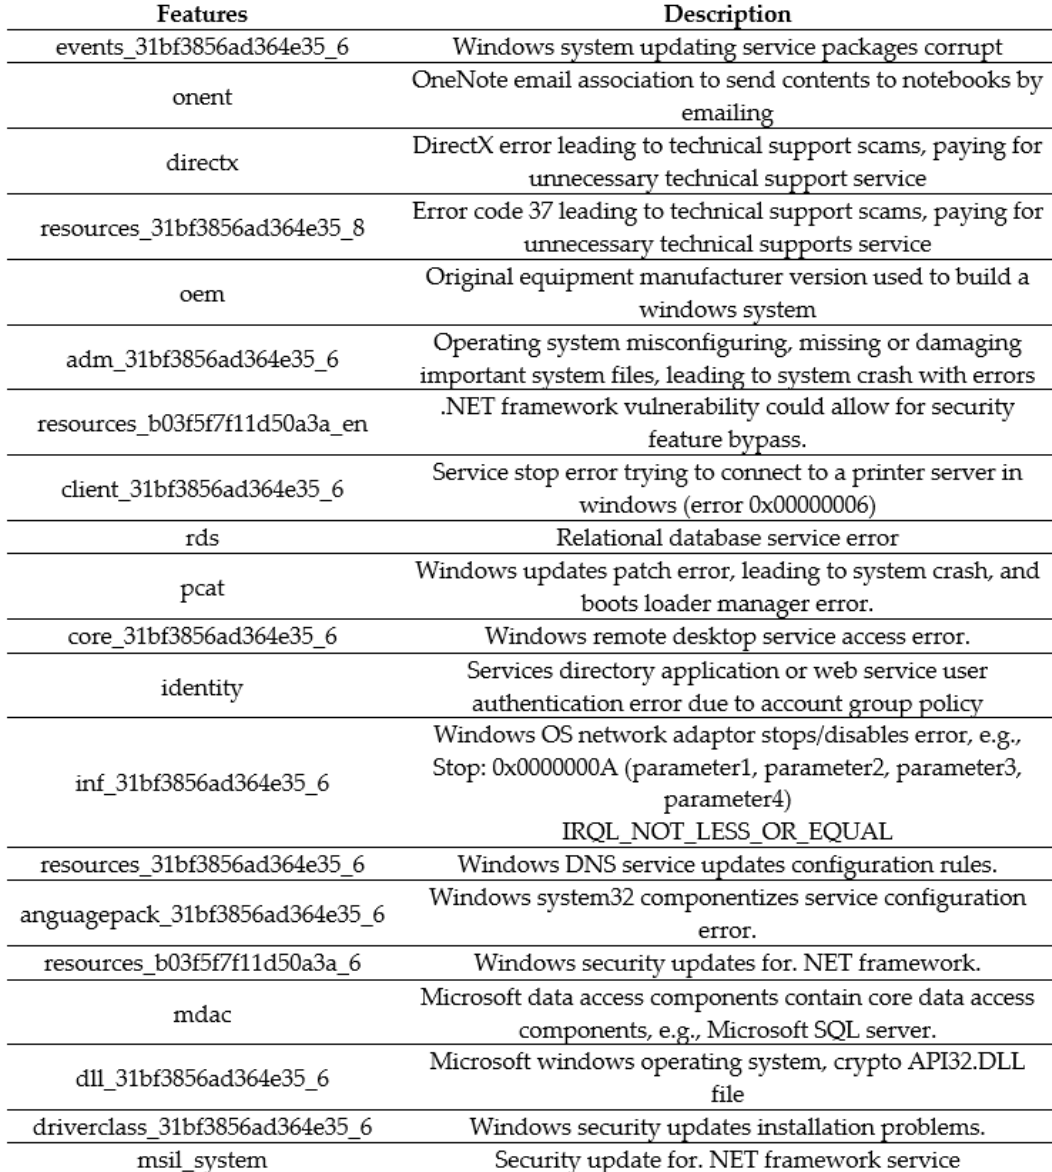
Figure 9. Dynamic analysis of malware features.